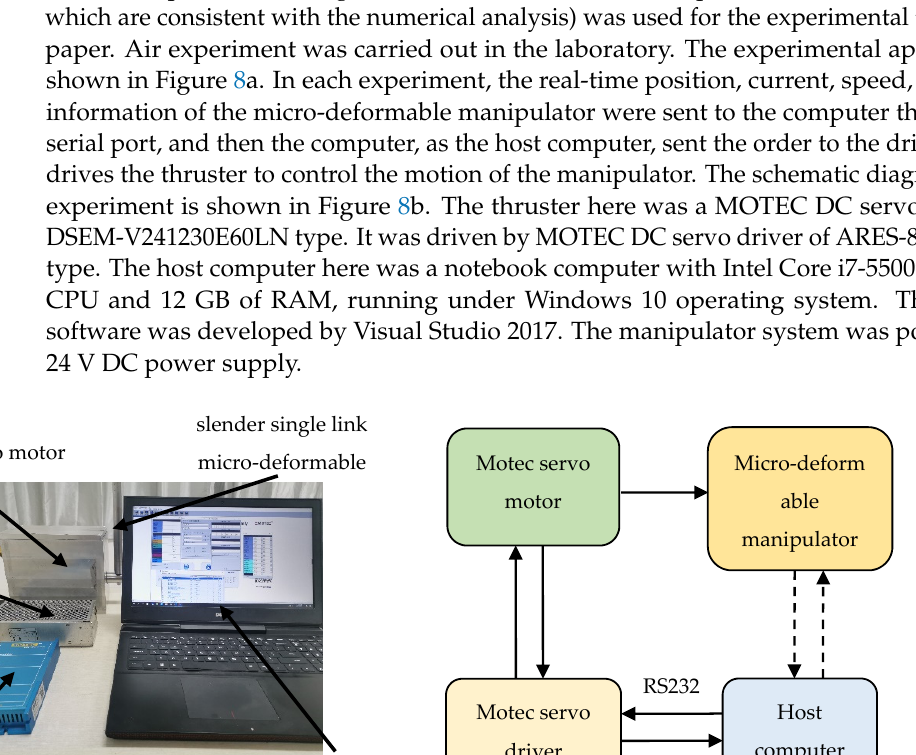
Figure 7. The control input τ and M results of different methods: ( a ) adaptive boundary method; ( b ) RBF neural network method; ( c ) the proposed method.